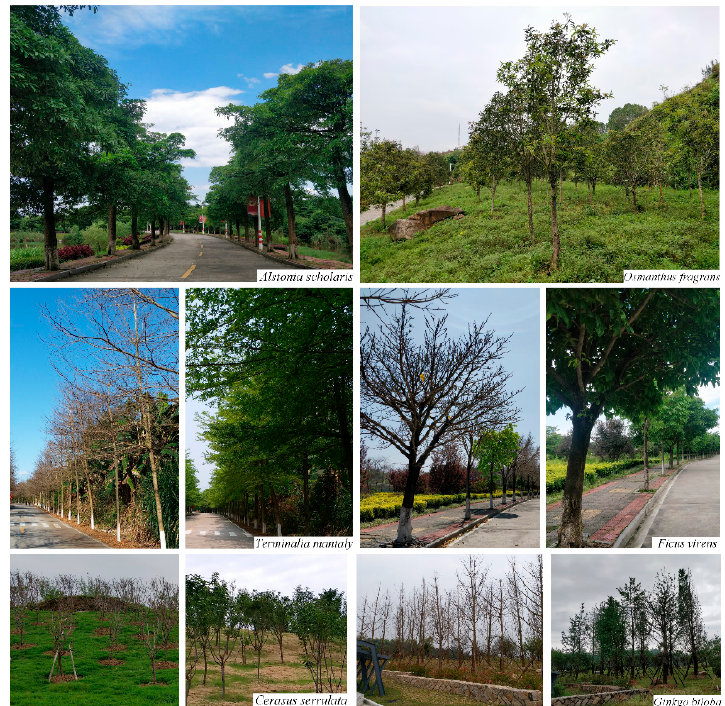
Figure 2. Ground perspective images of the six tree species. The first row shows Alstonia scholaris ( AS) and Osmanthus fragrans (OF), which are evergreen trees that keep their leaves at all times; the 2nd ( Terminalia mantaly— TM, and Ficus virens— FV) and 3rd ( Cerasus serrulata — CS, and Ginkgo biloba — GB) rows show deciduous trees under leaf-off and leaf-on conditions during the UAV campaigns.